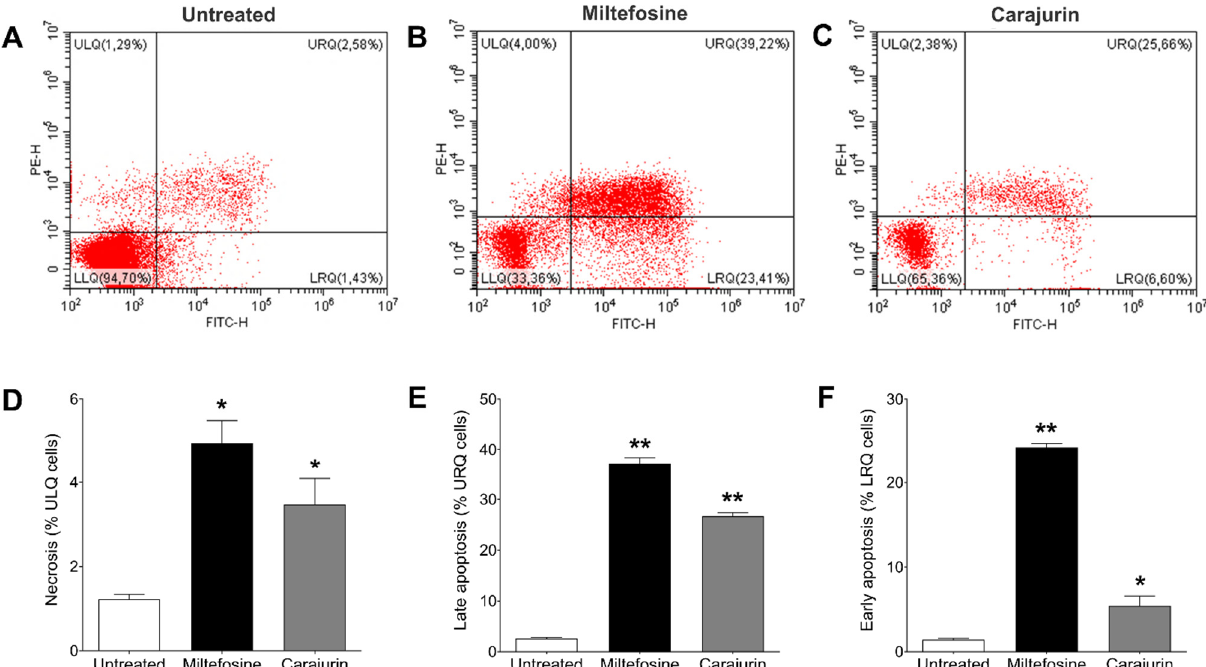
Figure 6. Changes in phosphatidylserine exposure and plasma membrane integrity in Leishmania amazonensis promatigotes treated with IC 50 of carajurin for 24 h. Parasites were labeled with Annexin V-FITC and PI. ( A ) Untreated promastigotes used as control. ( B ) Parasites treated with miltefosine, an apoptosis-inducing drug, at a concentration of 50 µ M. ( C ) Promastigotes treated with carajurin, at the IC 50 concentration (26.4 µ M). In ( D – F ), statistical differences between the percentage of necrotic, late apoptotic, and early apoptotic cells, respectively, are shown. In all, the results obtained in the groups treated with carajurin and miltefosine were statistically different when compared to untreated parasites. (*) p < 0.05; (**) p < 0.01, when compared to untreated parasites by Mann-Whitney test. ULQ: = upper left quadrant; URQ = upper right quadrant; LRQ = low right quadrant.